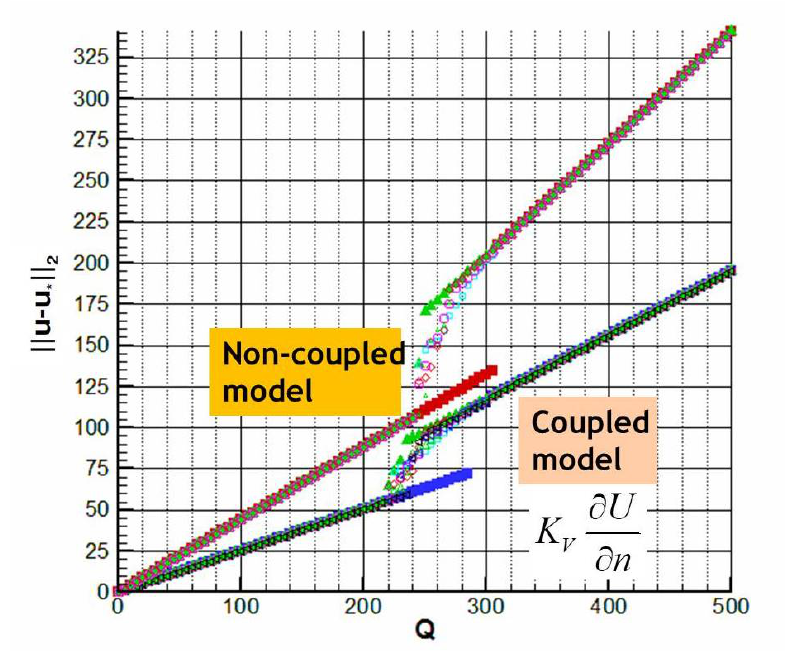
Figure 12. Approximated { ( Q , || u − u ∗ || 2 ) } diagrams for the coupled and the non-coupled